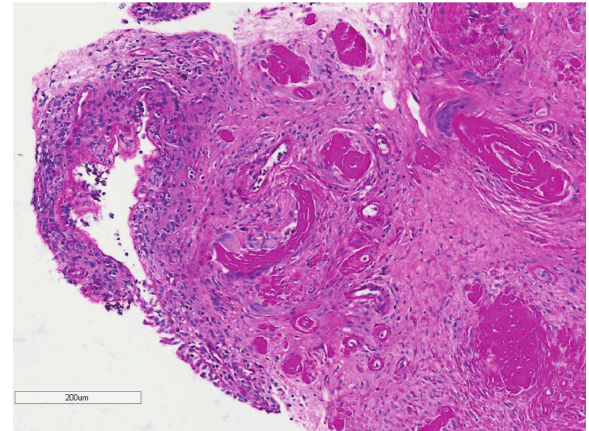
Figure 4 – Periodic Acid Schif (PAS) stain: eosinofi lic material deposits strongly positive by the PAS